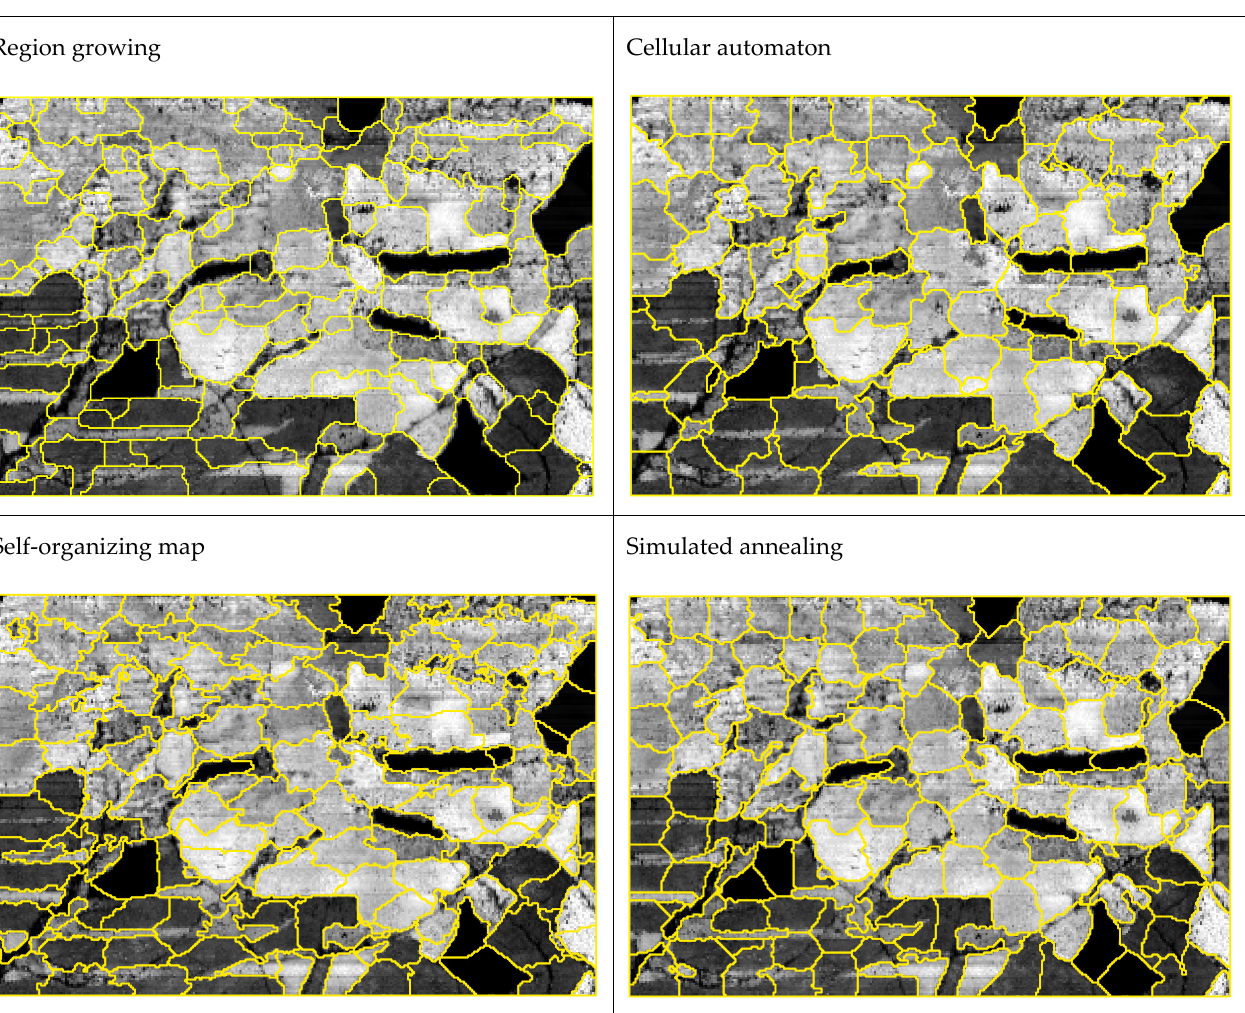
Figure 9. Segmentations produced by the four methods in case study area 1 (1.5 km × 1 km) overlaid with the 95th percentile of the height distribution of the echoes. Light tone indicates a high percentile value.